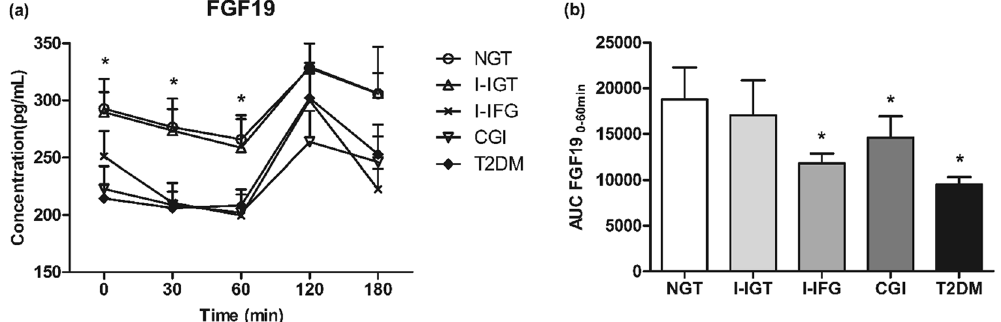
Figure 1. Fasting and postload FGF19 concentration (n = 245). ( a ) Dynamic change of serum FGF19 in different glucose tolerance status after OGTT. * P < 0.05 among the five groups. ( b ) AUC-FGF19 0–60 min in different glucose tolerance status. * P < 0.05 compared with NGT. Data are mean ±